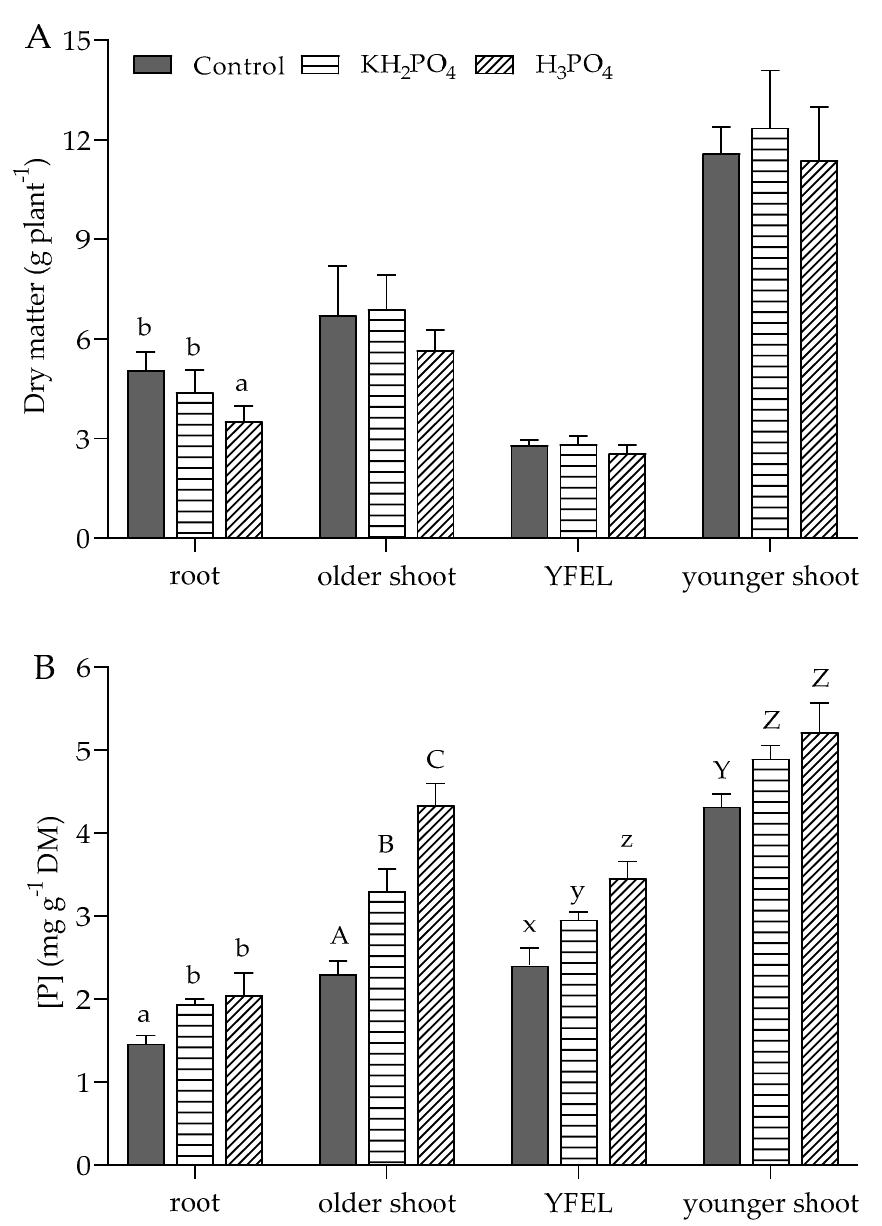
Figure 2. ( A ) Dry matter in g plant − 1 and ( B ) phosphorus concentration (P) in mg g − 1 dry matter at BBCH 16 (6th leave unfolded) following the three treatments: control without P fertilization (control) or three foliar applications of 200 mM potassium dihydrogen phosphate (KH 2 PO 4 ) or phosphoric acid (H 3 PO 4 ) at 40, 46, and 53 days after sowing. Maize plant material was separated into root, older shoot, youngest fully developed leave (YFEL), and younger shoot. Bars represent means + SD ( n = 5). Upper and lower case letters indicate significant differences between treatments within the examined parameters (ANOVA with Duncan test, p ≤ 0.05).